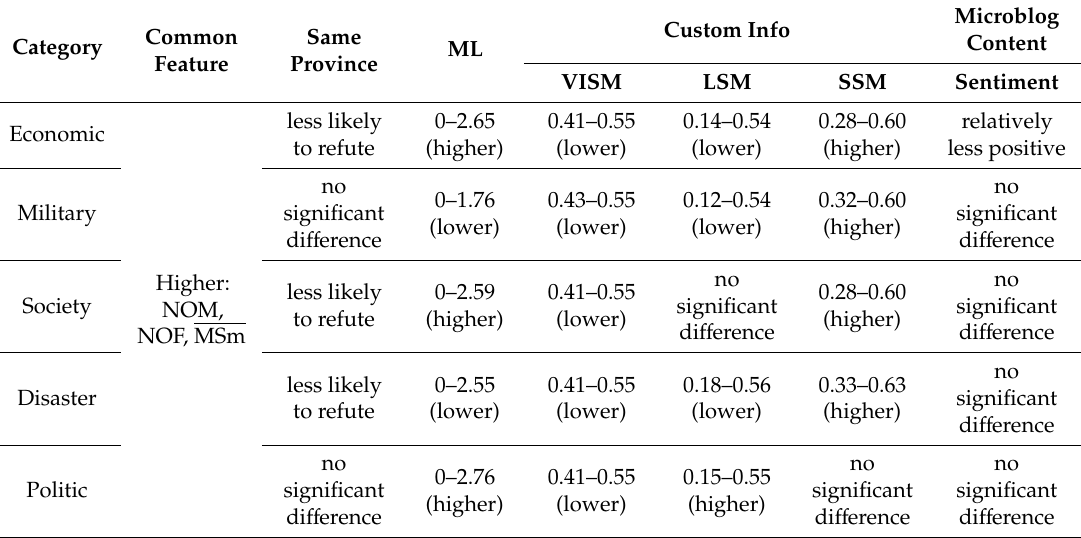
Table 8. Features of the rumor refuters compared with the rumor